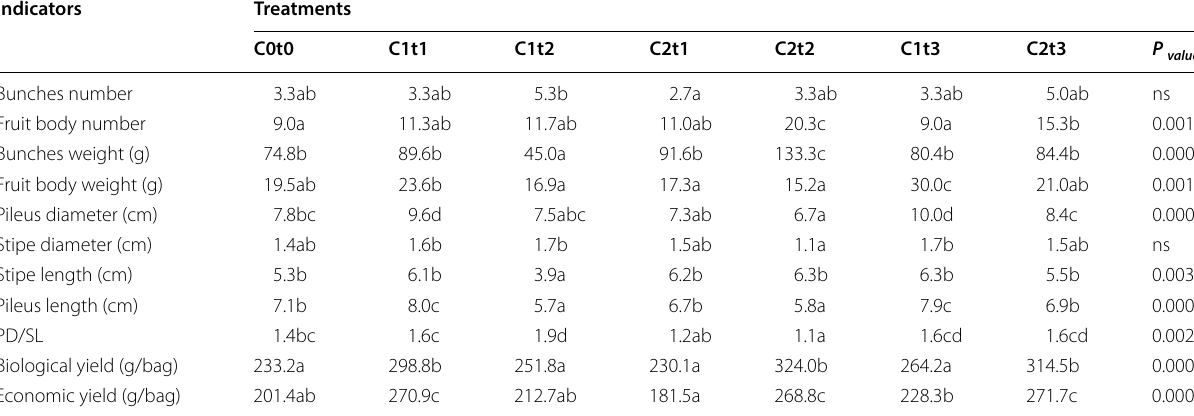
Values are means; means within the same row followed by the same letters are not significantly different at P < 0.05 according to Duncan’s multiple range test, ns: non-significant effect